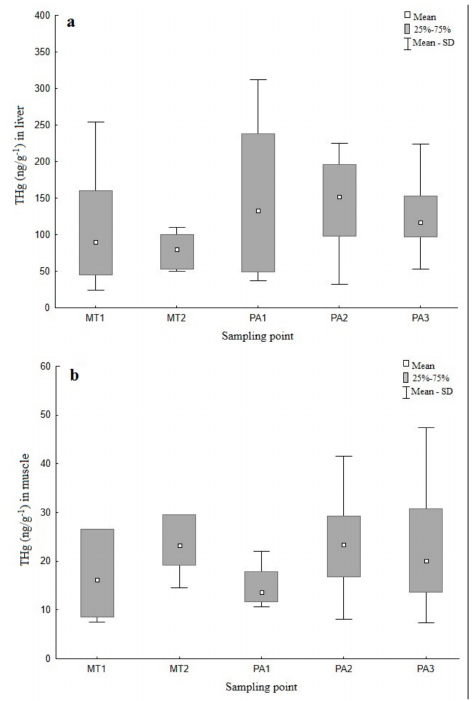
Figure 3. Total mercury concentration (THg) (ng g − 1 ) in the liver ( a ) and muscle ( b ) of Podocnemis unifilis across sampling